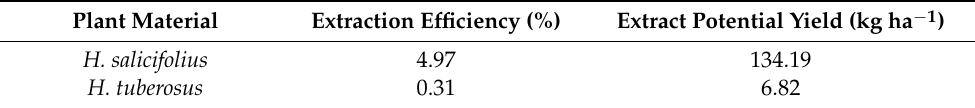
Table 2. Extraction efficiency and extract potential yield of H. salicifolius and H. tuberosus from dry biomass under supercritical conditions with the participation of water as a co-solvent (CO 2 + H 2 O extracts).